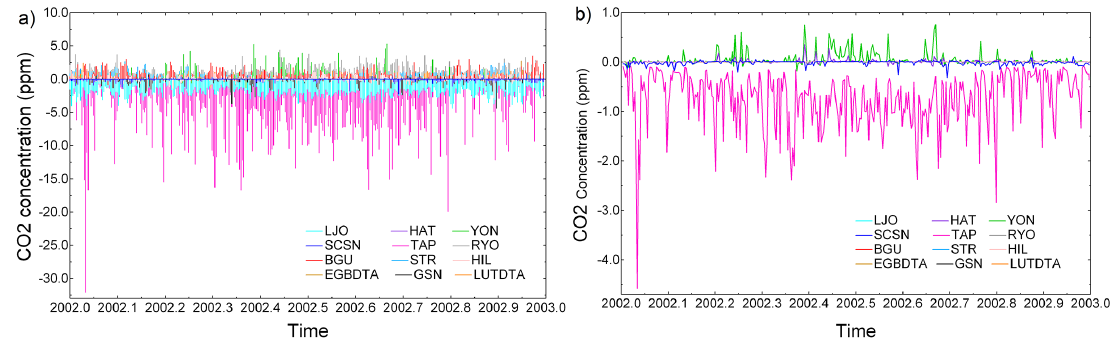
Figure 5. Simulated PCTM surface CO 2 concentration difference (experiment minus control, units: ppm) at the 12 GLOBALVIEW mon- itoring stations with the largest concentration difference. (a) Hourly mean CO 2 concentration difference; (b) local afternoon mean CO 2 concentration difference.